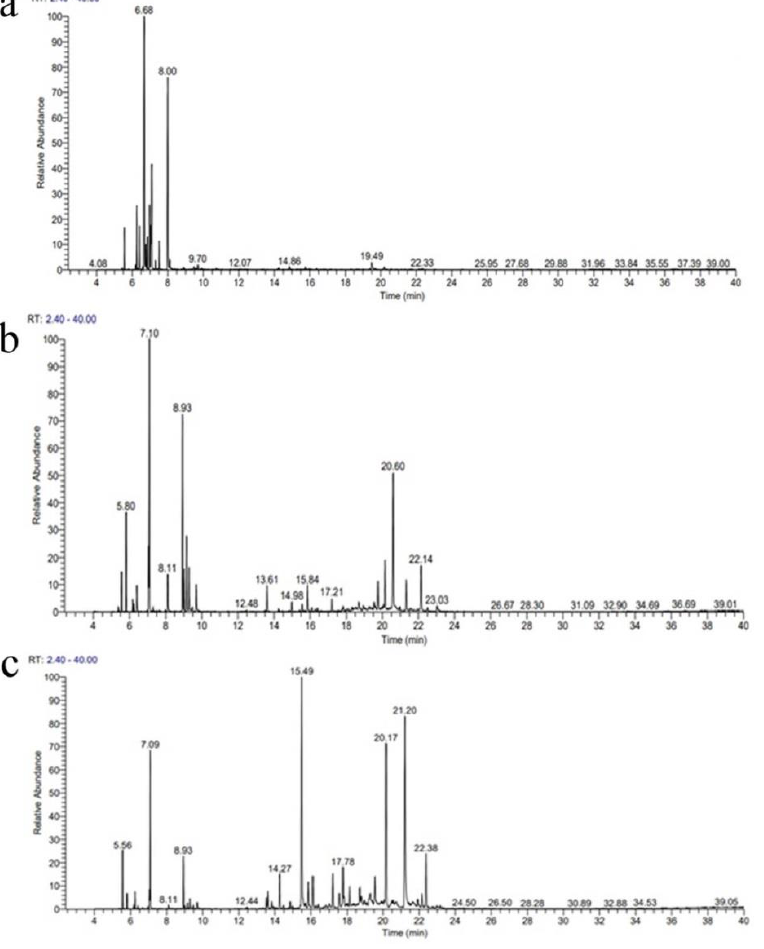
Figure 1. The chromatograms of GC-MS analysis of C. longa ( a ), C. aromatica ( b ), and C. angustifolia ( c ) leaf essential oil.